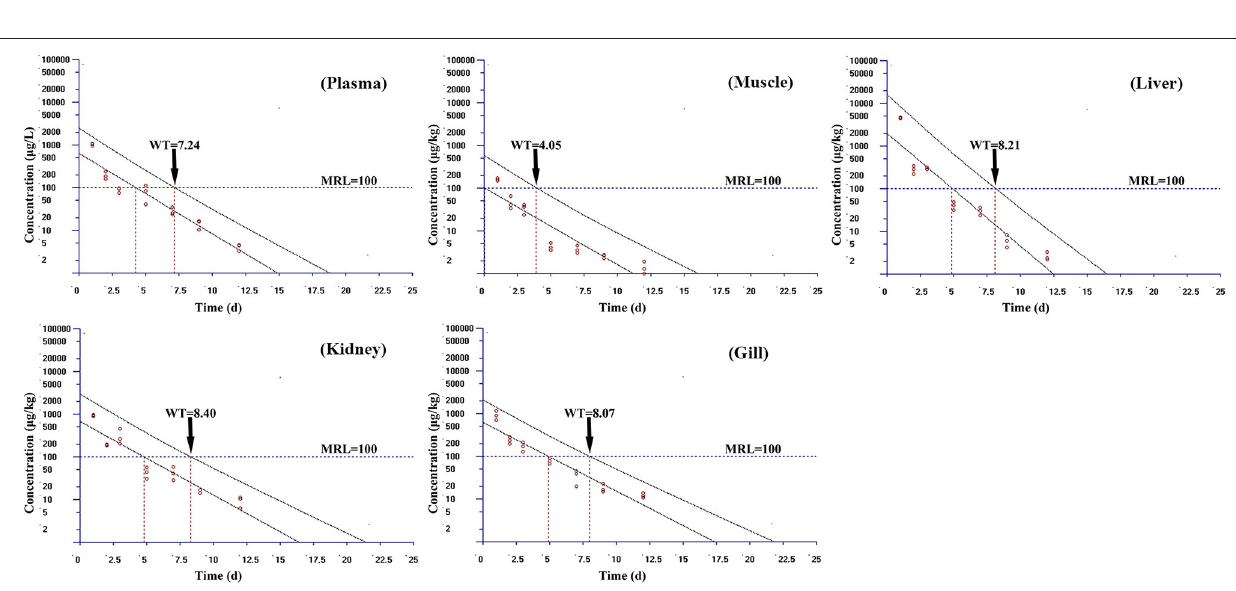
Frontiers in Veterinary Science |